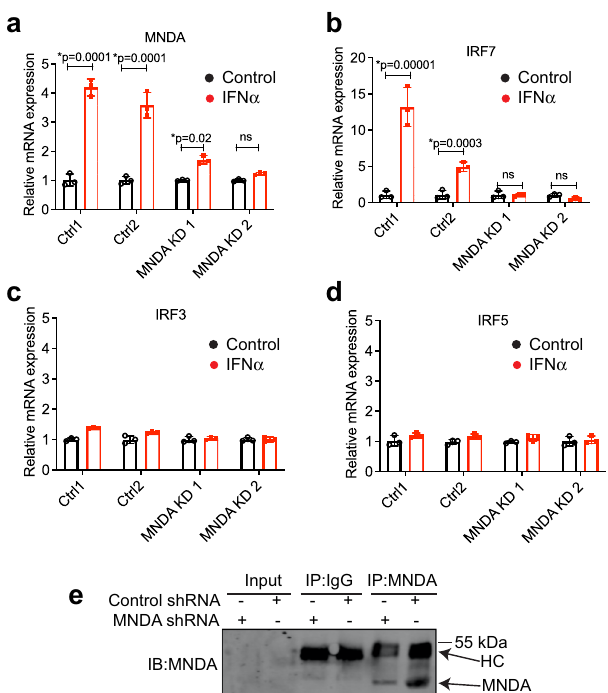
Fig. 5 MNDA is required for IRF7 induction in pDCs. a – d Quantitative PCR analysis of MNDA ( a ), IRF7 ( b ), IRF3 ( c ) or IRF5 ( d ) mRNA in CAL-1 cells expressing control or MNDA shRNA and stimulated with IFN α (1000 U/ ml) for 16 h. e Anti-MNDA immunoblot (IB) of MNDA immunoprecipitated (IP) from cells treated with control or MNDA shRNA, showing effect of MNDA shRNA on MNDA protein expression. HC, antibody heavy chain. Immunoblot is representative of three experiments. All data are mean ± SD of triplicate samples and are representative of three independent experiments; two tailed unpaired Students t test; * p < 0.05 indicates signi fi cance compared to respective groups; ns indicates not signi fi